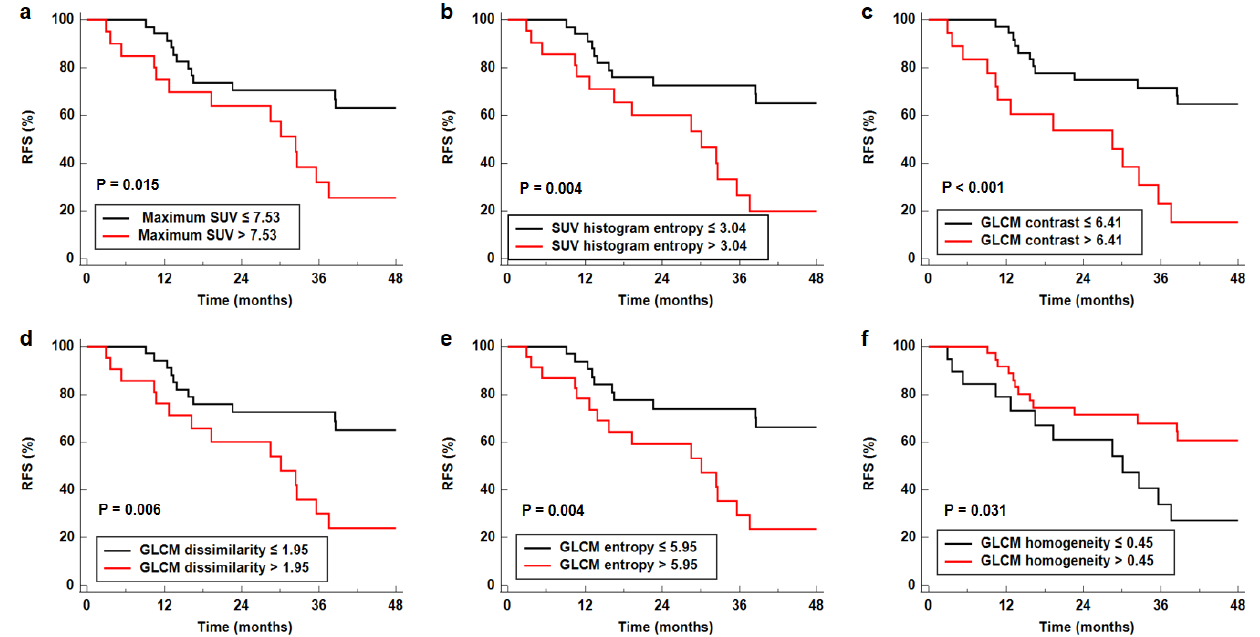
Figure 3. Cumulative RFS curves according to the cut-off values of maximum SUV ( a ), SUV histo- gram entropy ( b ), GLCM contrast ( c ), GLCM dissimilarity ( d ), GLCM entropy ( e ), and GLCM ho- mogeneity ( f ). p -values are the results of the log-rank test.